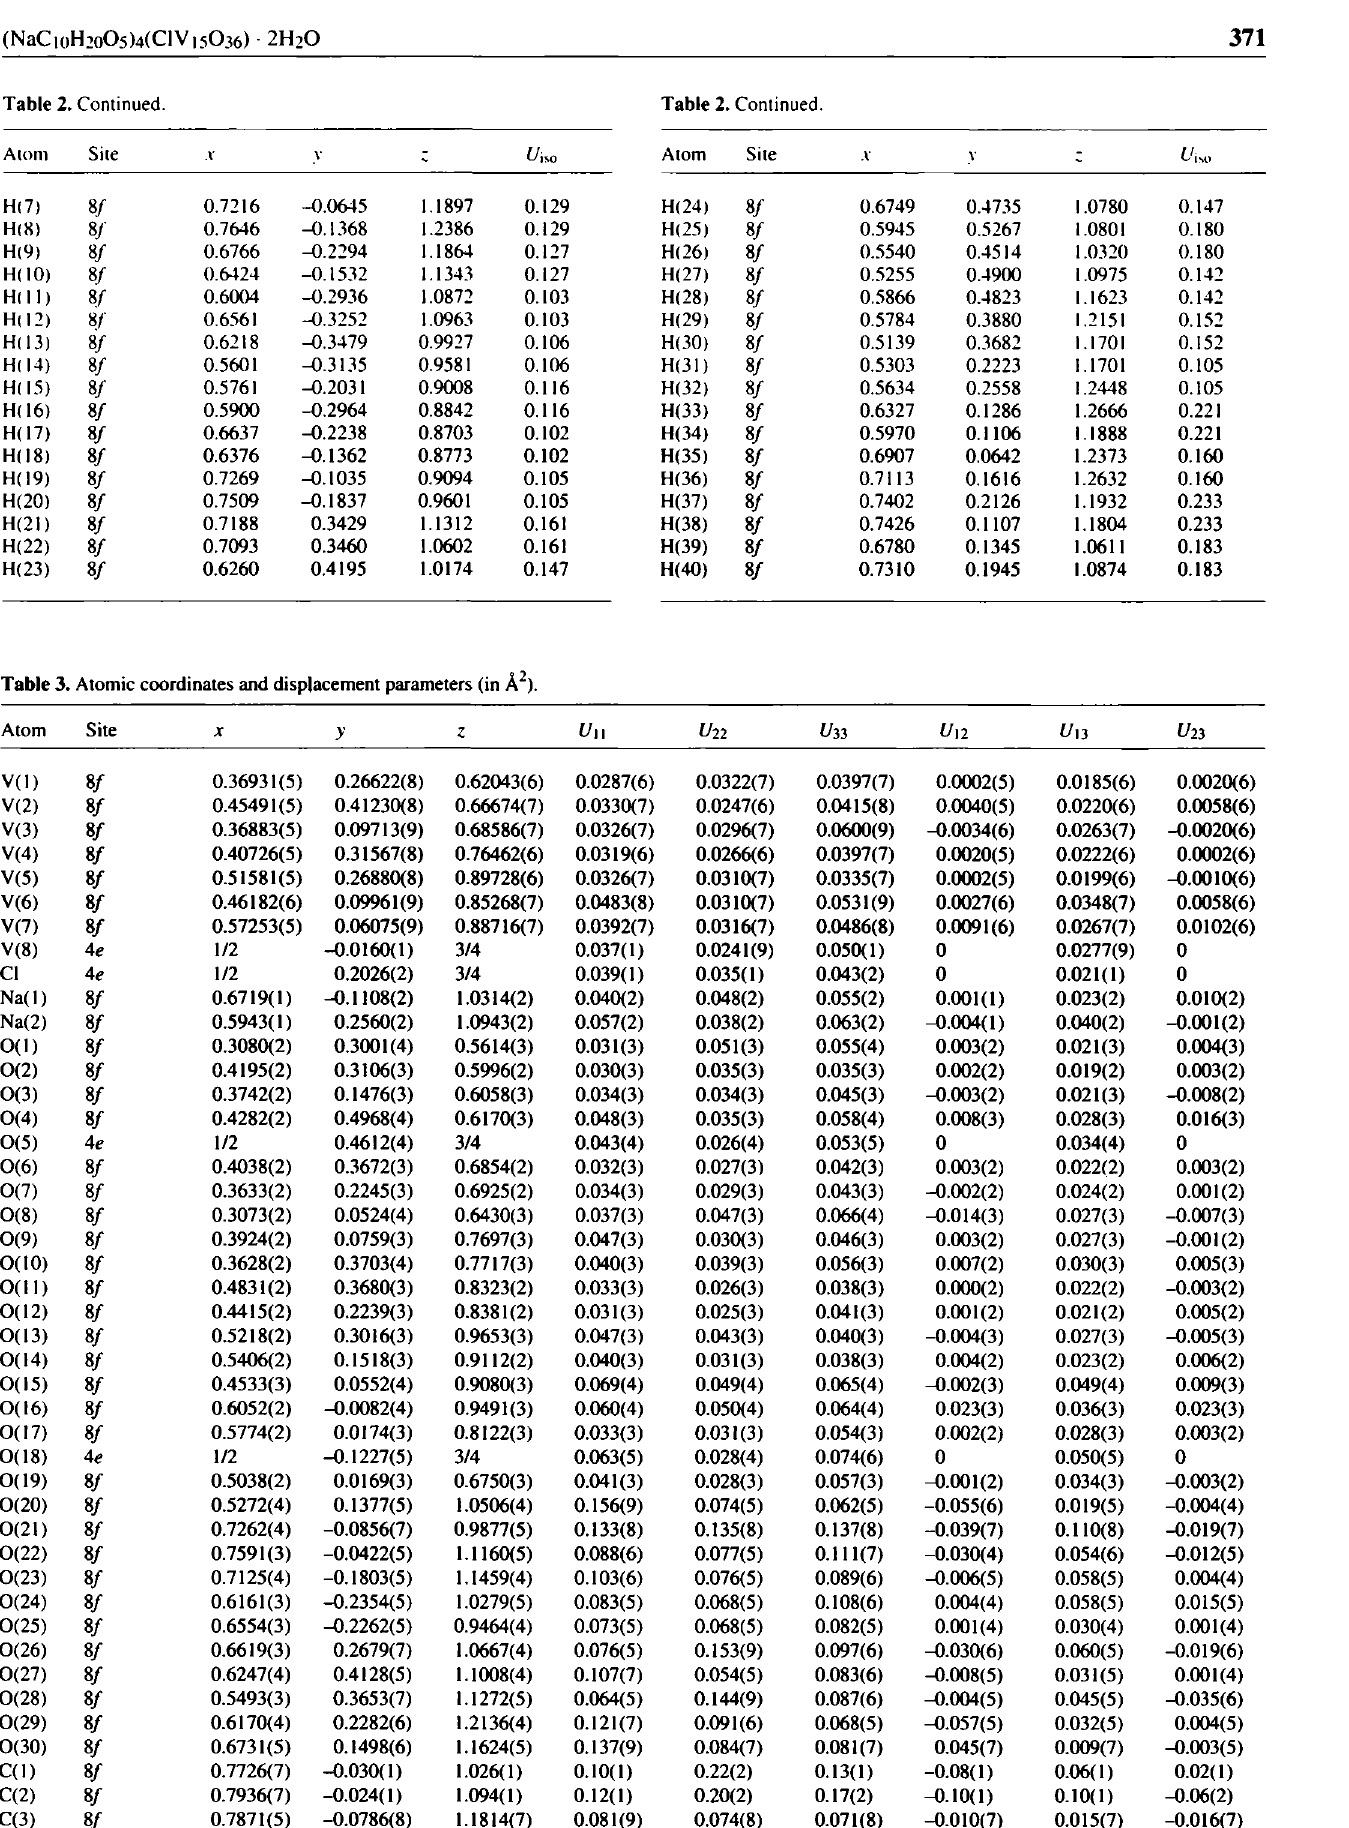
Table 3. Atomic coordinates and displacement parameters (in A 2